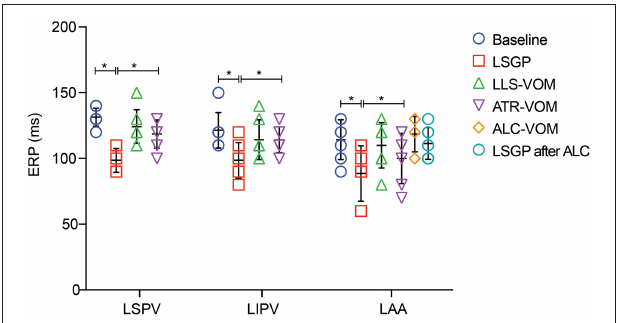
FIGURE 3 | Effective refractory period at left superior pulmonary vein (LSPV), left inferior pulmonary vein (LIPV), and left atrial appendage (LAA). LSGP, left superior ganglionated plexi; LLS, low-level VOM stimulation; ATR, atropine; ALC, alcohol; VOM, vein of Marshall; * P < 0.05.